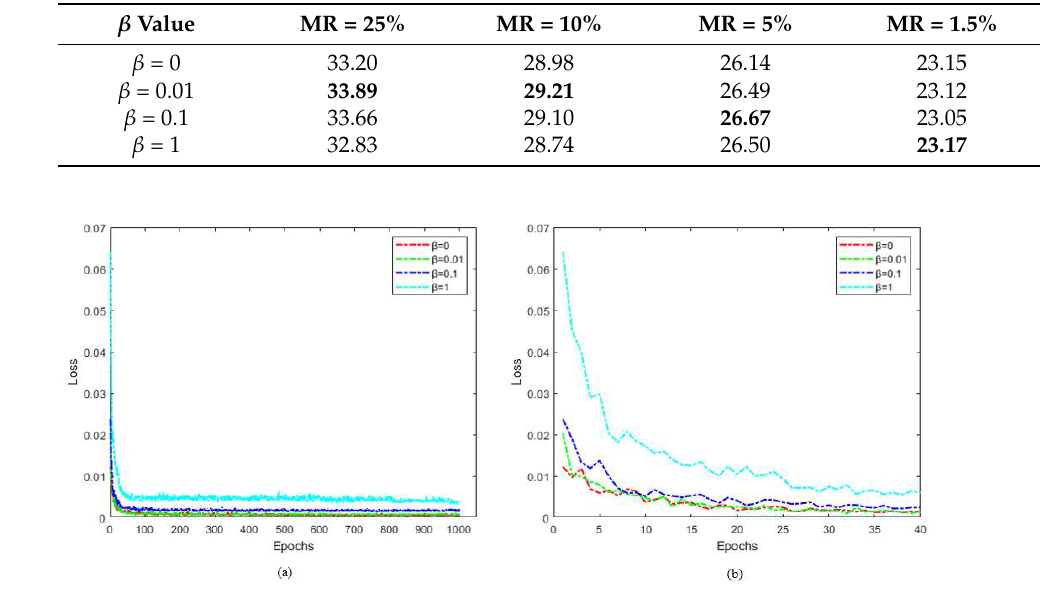
Table 2. Test set performance comparison in terms of the average PSNR (dB) with different β values under different MR. The best performances are marked in bold.